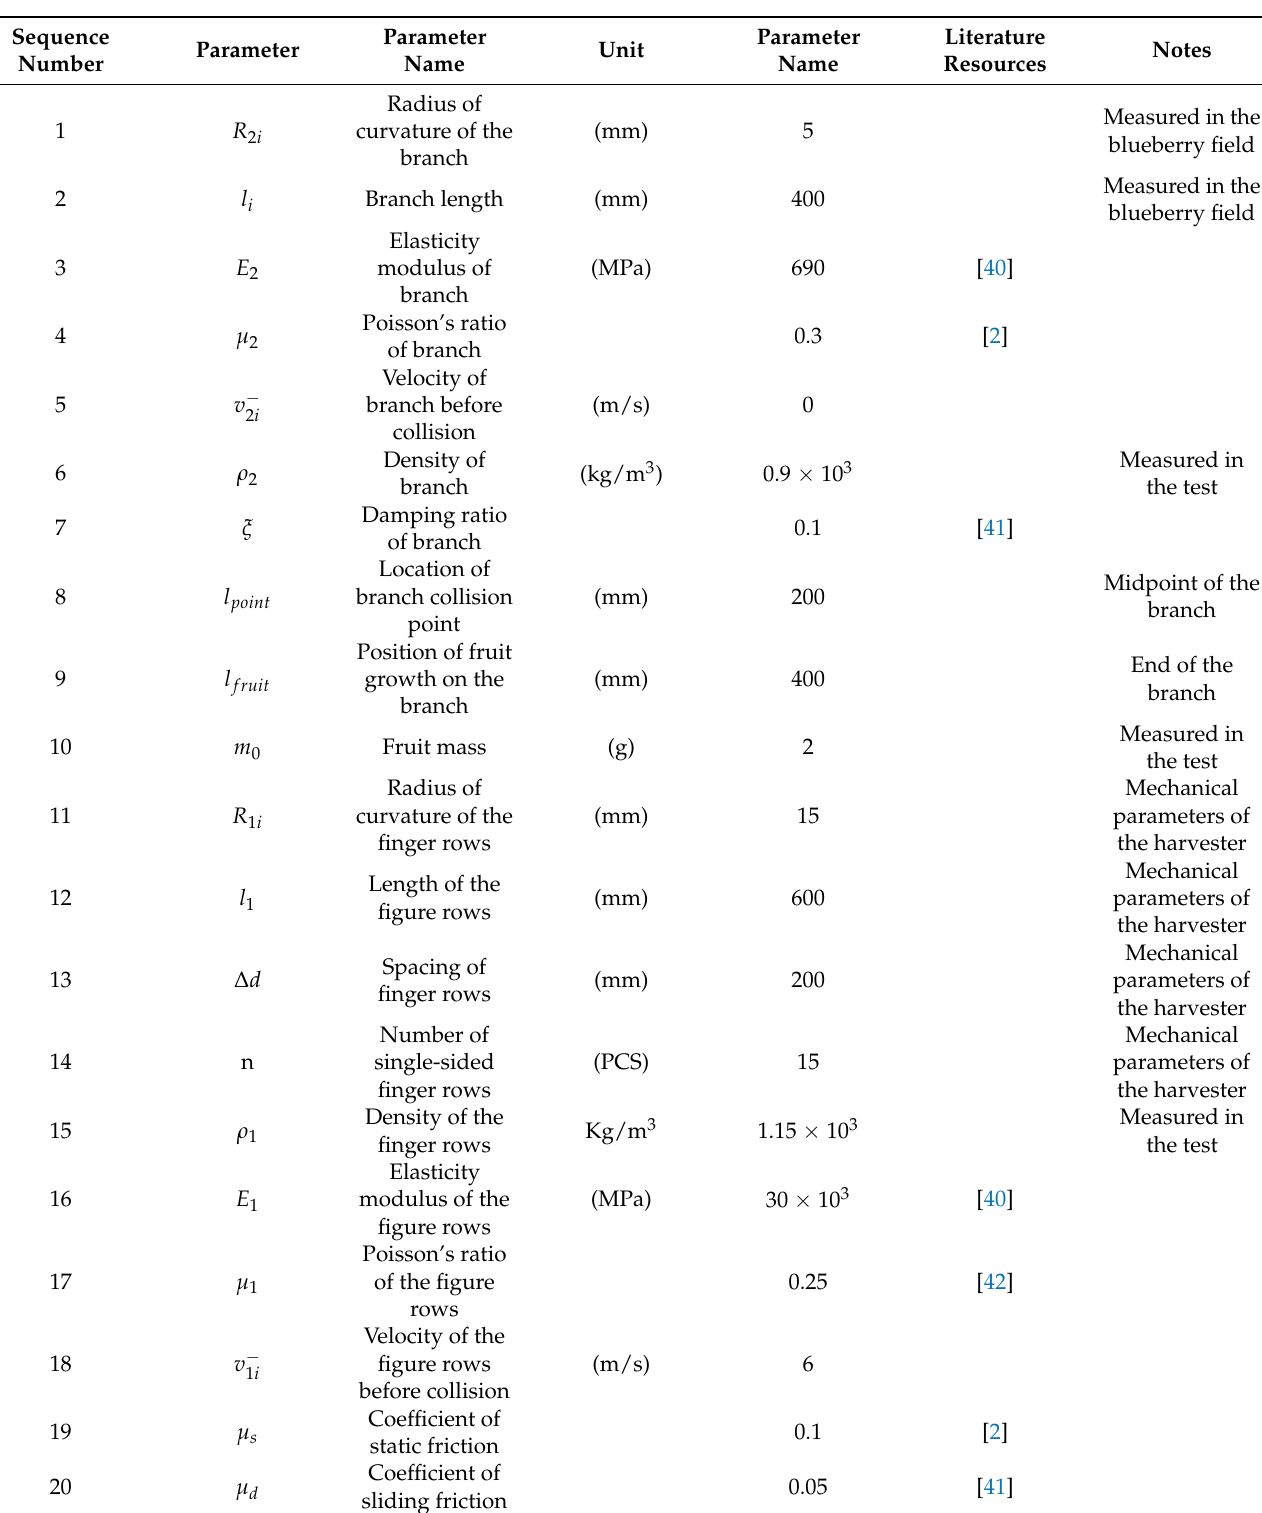
Table 2. Summary table of parameter